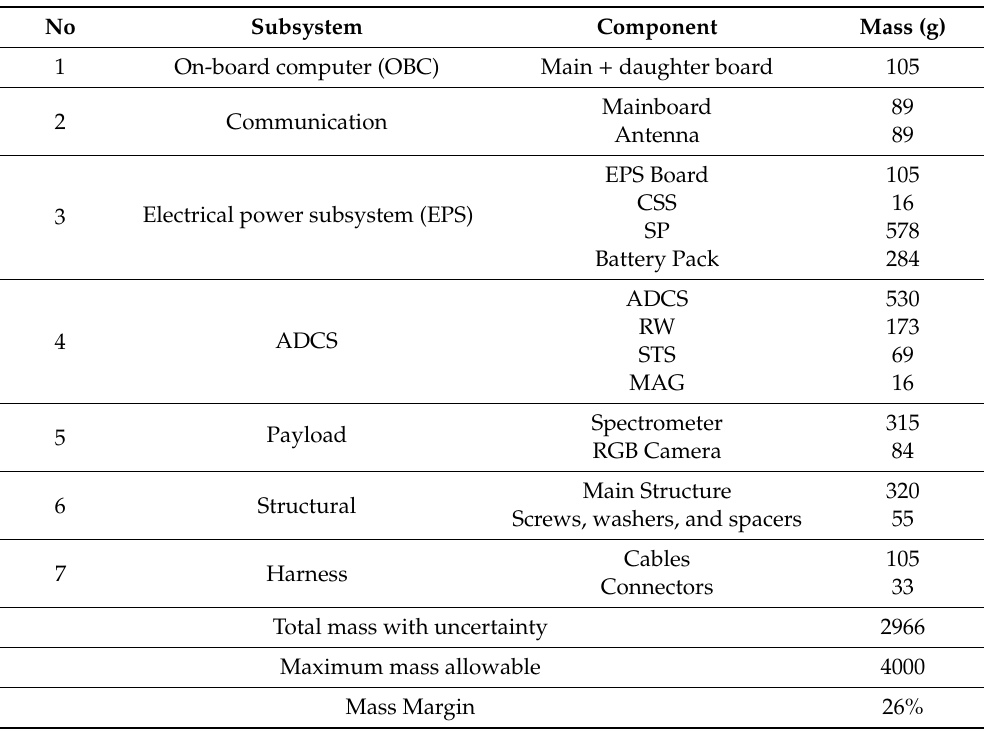
Figure 17. Fit check using 3D printed structures. Bottom 2U fitcheck ( left ) and top 1U fitcheck ( right ). MeznSat mass budget is shown in Table 2. The results show that the satellite mass was found to be 2966 g with a mass margin of 26% from the maximum mass of 4 kg identified by the CubeSat Standard [27]. Table 2. MeznSat mass budget.